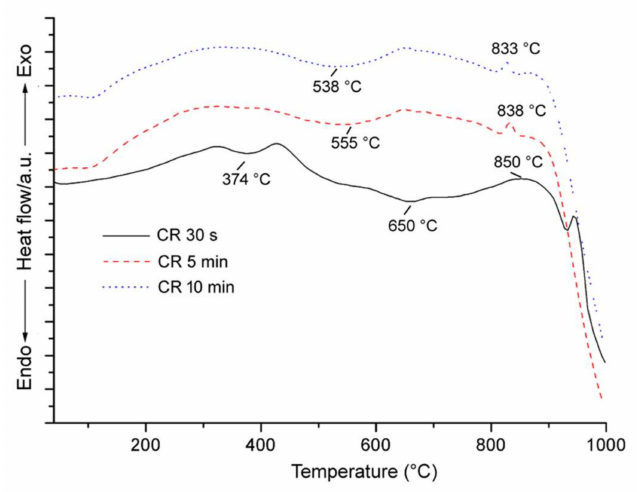
Figure 7. Differential scanning calorimetry of crocidolite after 30 s, 5 min and 10 min of grinding